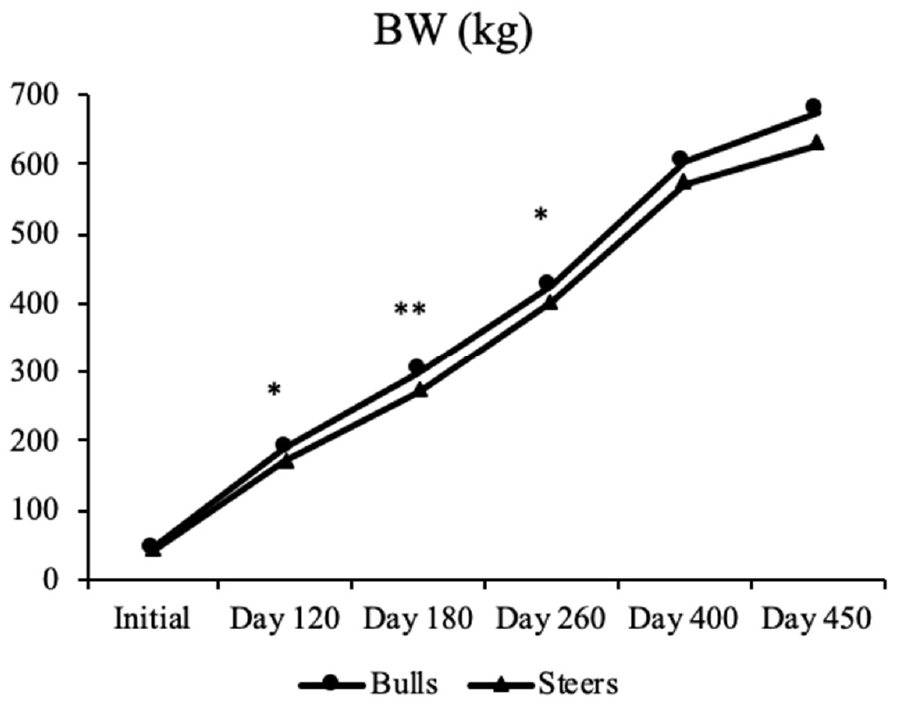
Figure 2. Comparison of BW between bulls and steers. * p < 0.05; ** p < 0.01. Table 2. Effect of early castration on carcass characteristics of the Holstein cattle.